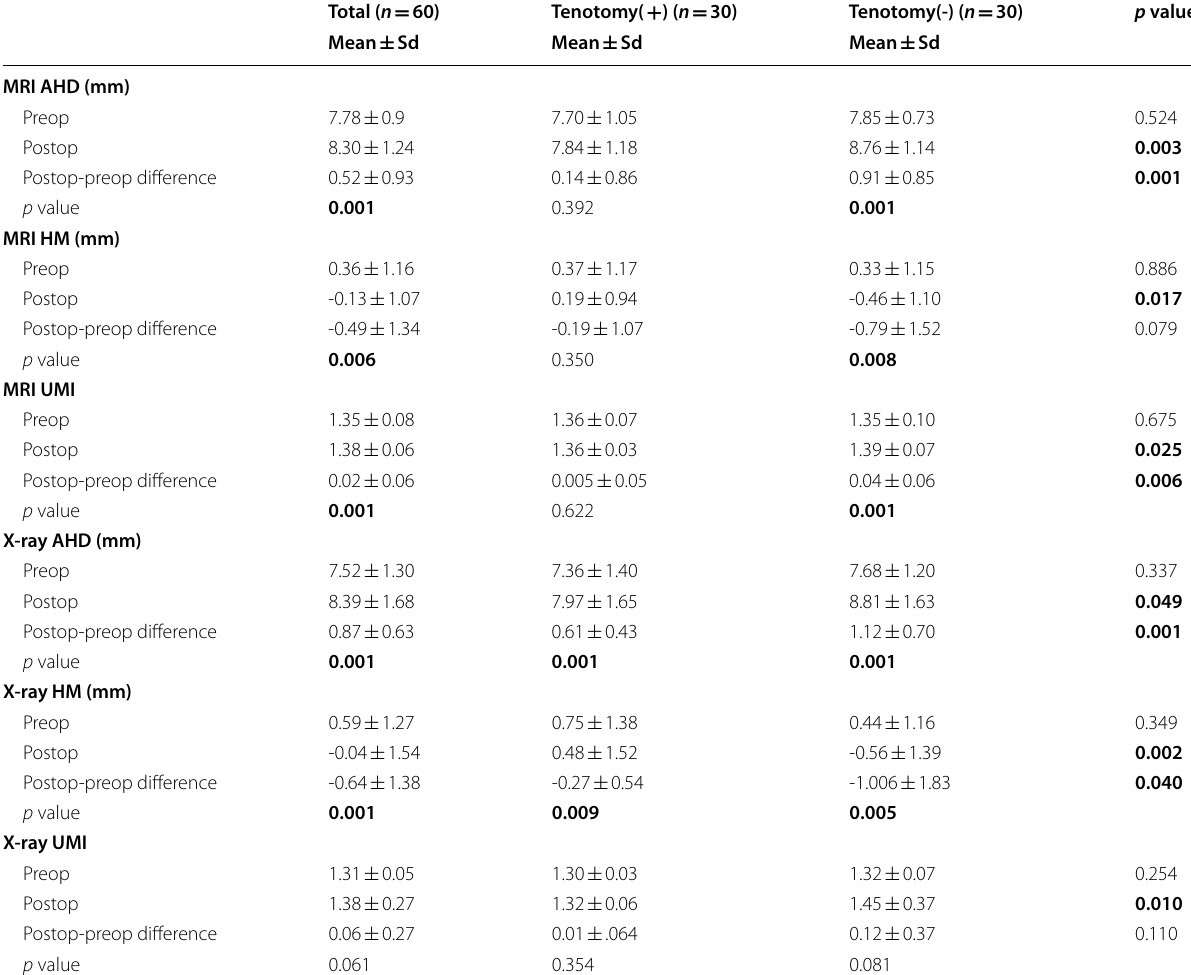
Table 4 Pre- and postoperative radiological measurement values of the patients